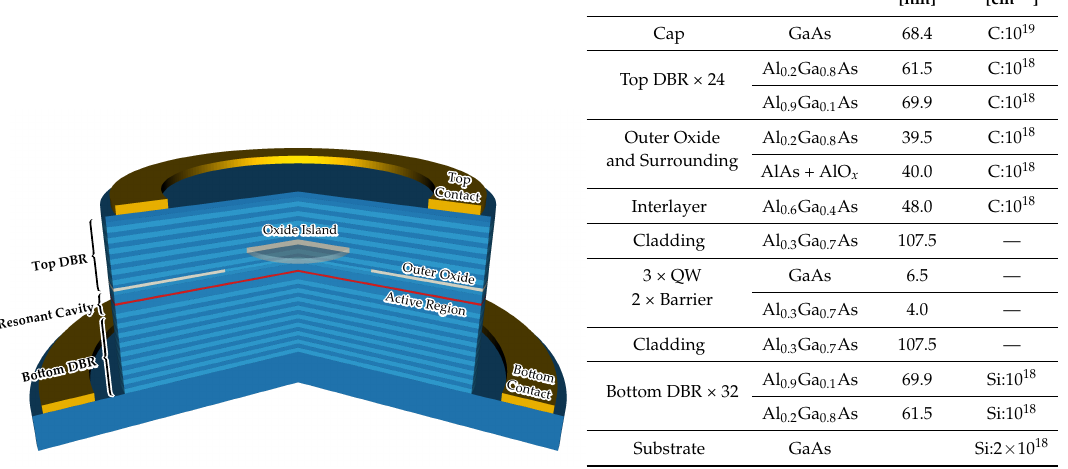
Figure 1. Schematic diagram and layers summary of the analyzed VCSEL. In the image, the active region is marked in red and there are two oxide layers (marked in beige). The outer layer, manufactured classically, is at the edge of the cavity, and the oxide island (shown in full) is in one of the Al 0.9 Ga 0.1 As layers in the top